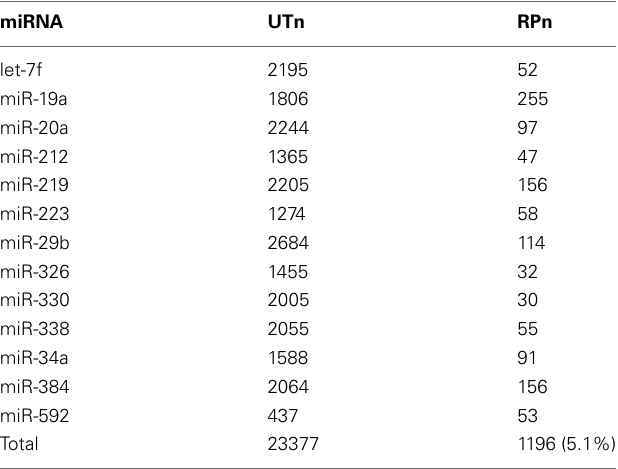
Table A4 | Reduction in target gene list size resulting from rank product